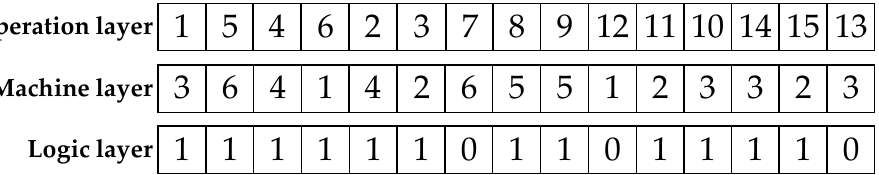
Figure 5. An examples of new coding methods designed in this article.